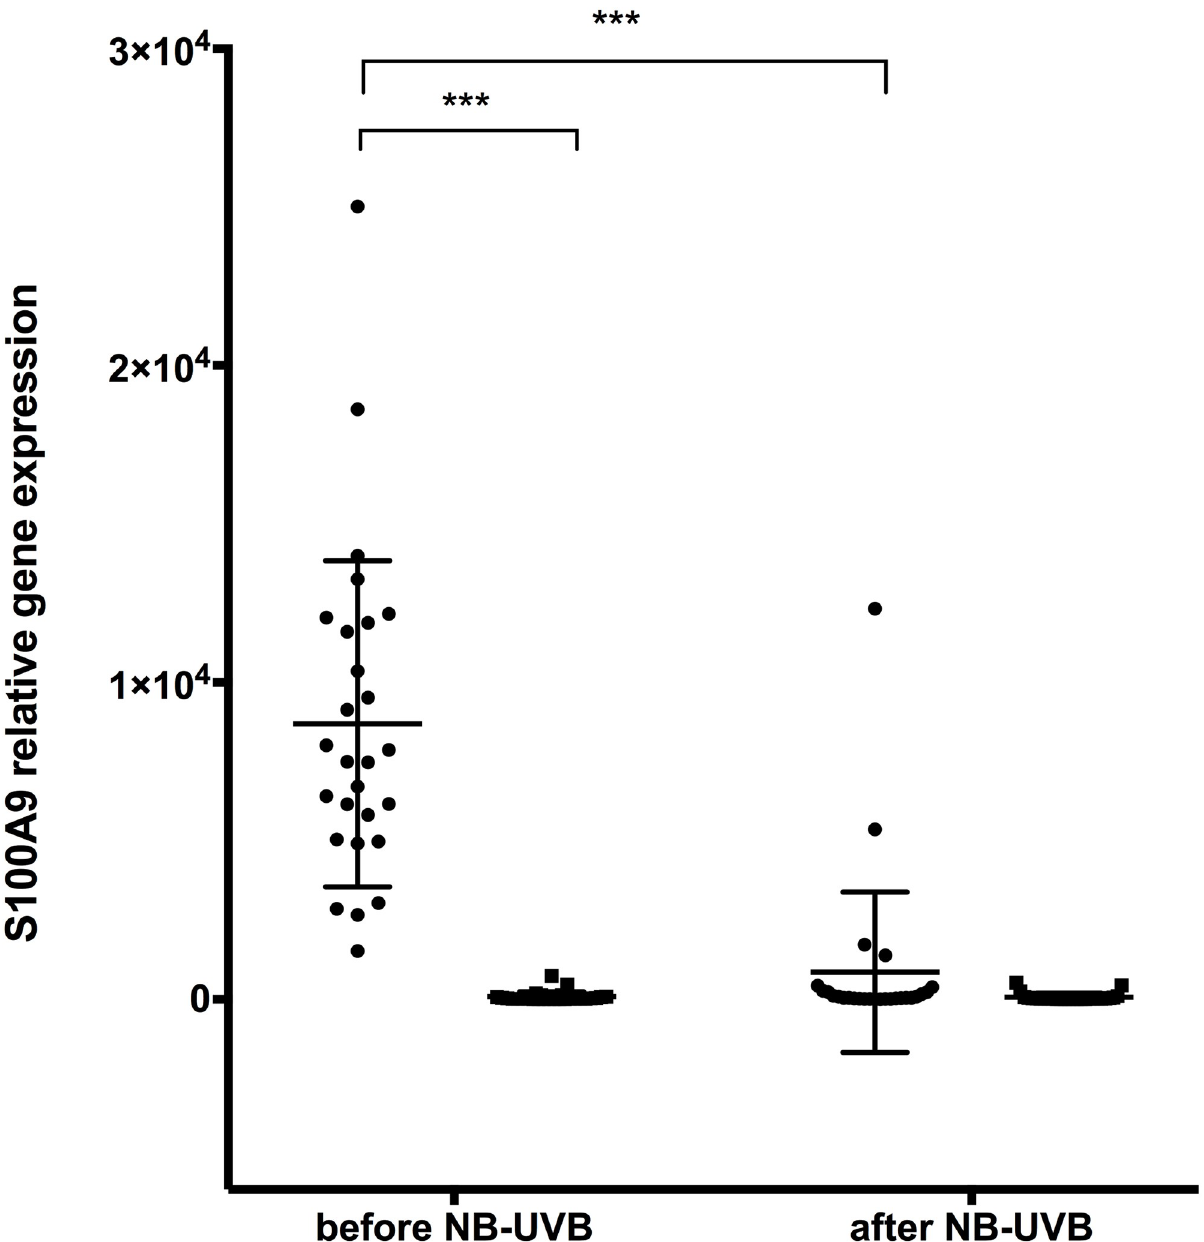
Fig 3. Relative gene expression of S100A9 in lesional and non-lesional skin of patients with psoriasis before and after NB-UVB treatment. n = 27, ● = lesional skin, ■ = non-lesional skin. ( ��� p < 0.001).